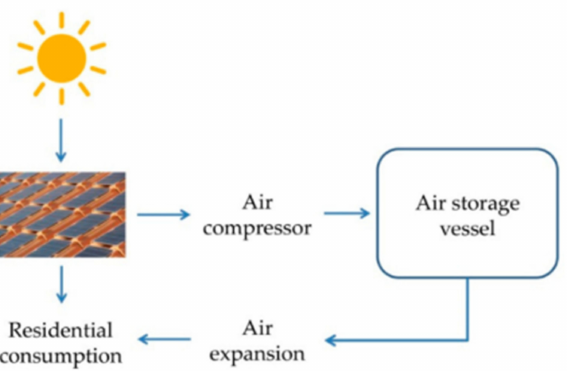
Figure 3. Compressed air energy storage system (CAES system) connected with the residential photovoltaic (PV) plant [6]. No changes were made to the original